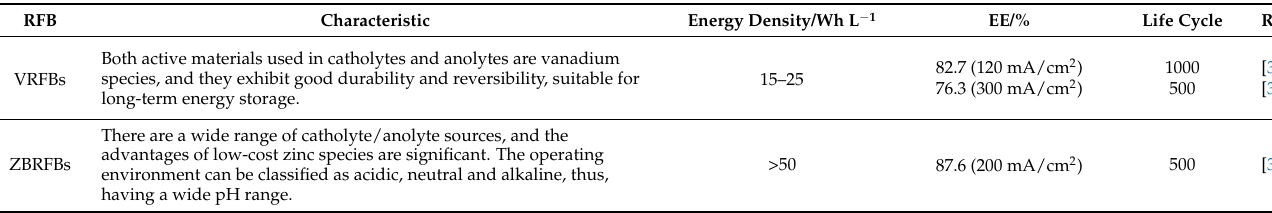
Table 1. Comparison of VRFBs and